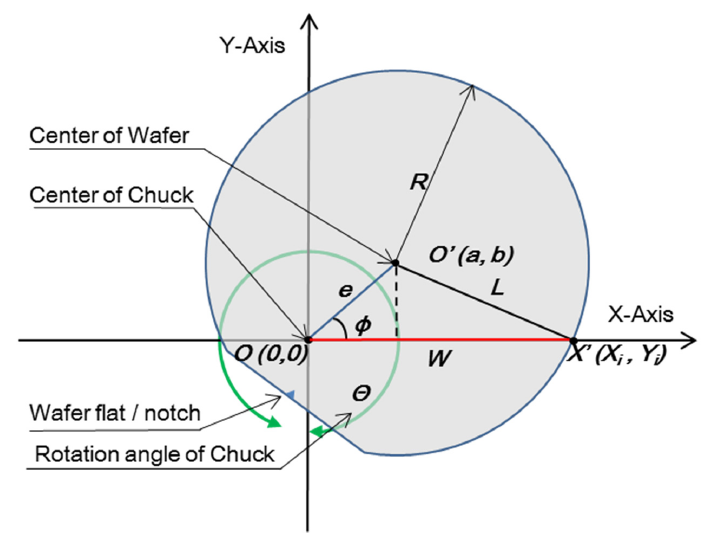
Figure 2. Wafer alignment with offset compensation methodology.